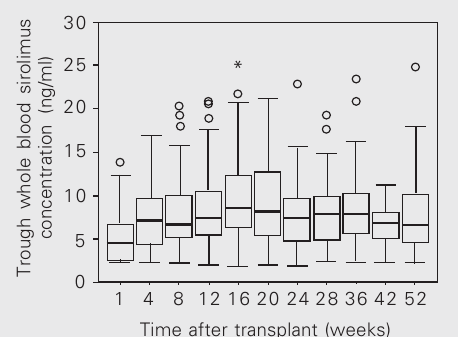
Figure 3. Serum creatinine con- centrations in patients receiv- ing sirolimus or azathioprine during the first year after trans- plantation. The middle horizon- tal thick bar is the median; the top and bottom square lines indicates the 75th and 25th percentiles; the error bars de- note the limits of the 90th and 10th percentiles; open circles are outliers. P > 0.05 compar- ing sirolimus and azathioprine values on the occasion of each visit (unpaired Student t -test).